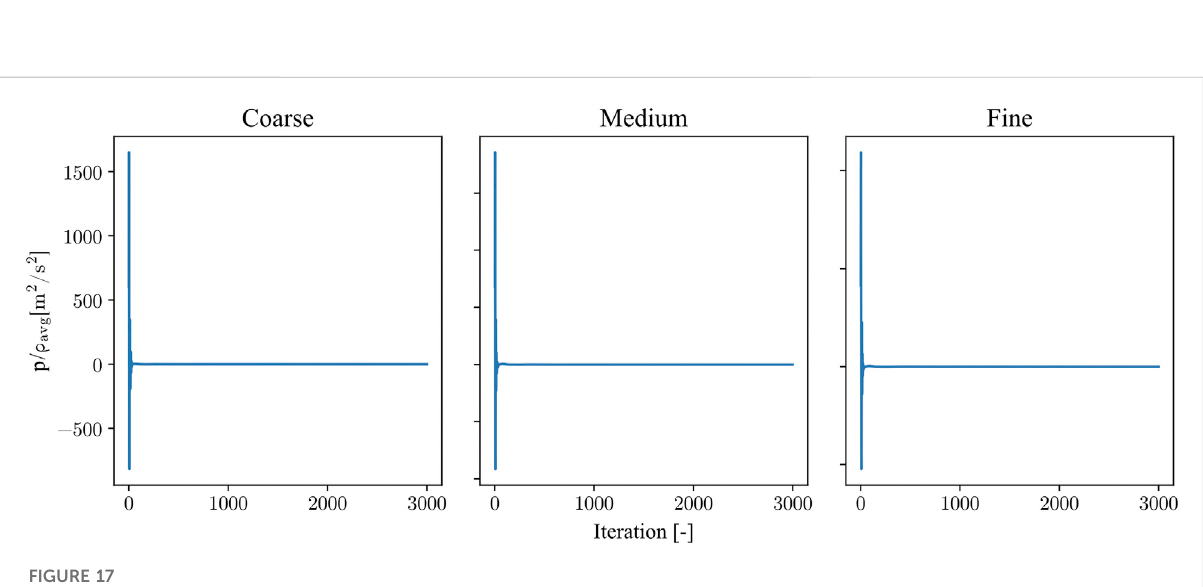
FIGURE 17 Convergence of the average pressure over one building.